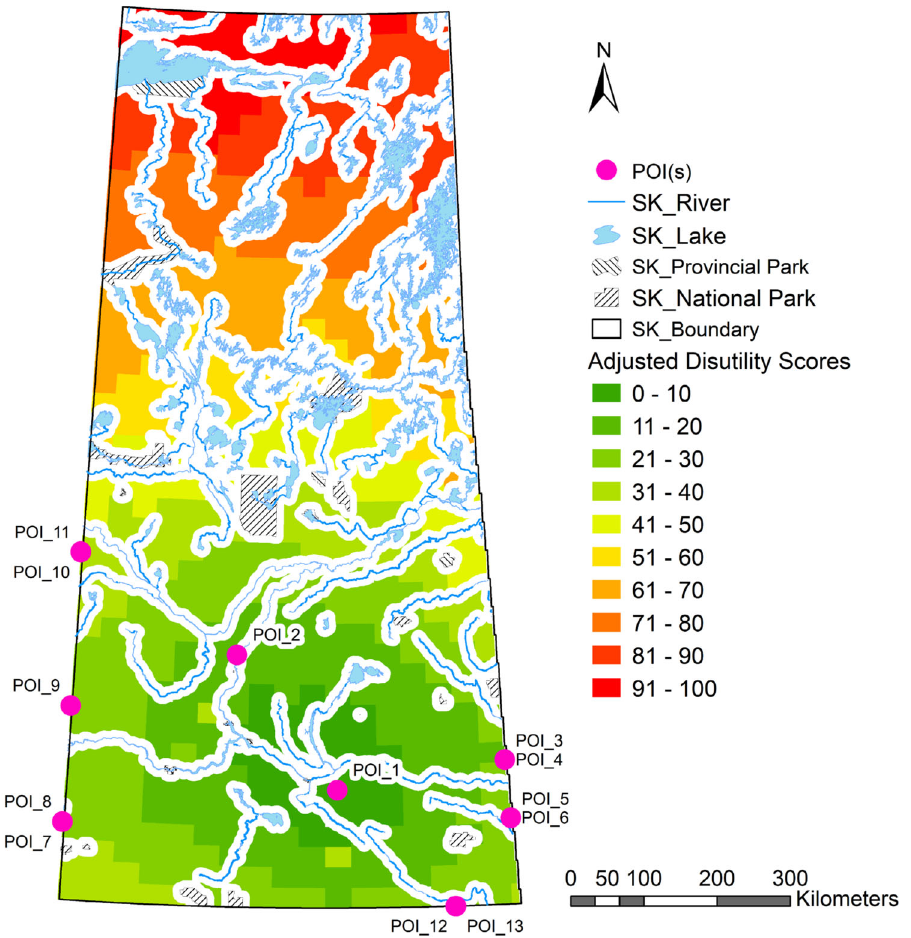
Fig. 5 Case I heat